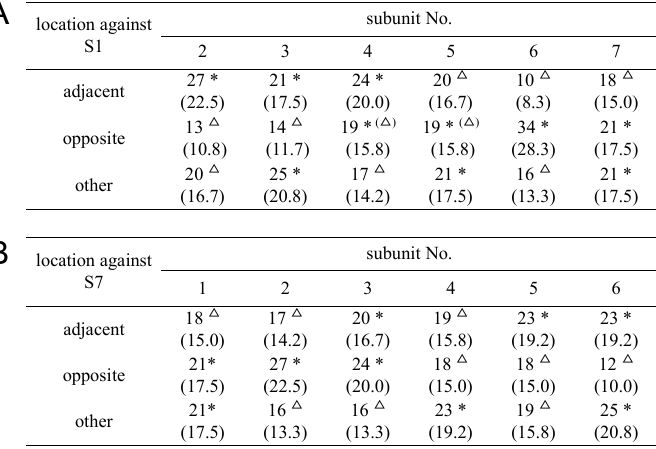
The number of each subunit located at “adjacent,” “opposite” and “other” is counted in the 60 pores on the basis of S1 (A) and S7 (B). The top three subunits located at each position at high-probability are marked with asterisks. In contrast, the worst three subunits located at each position are marked with triangles. The numbers in parentheses mean the probability (percentage) in 60 pores. By using the top three subunits at high-probability and three worst subunits, HP and LP arrangement patterns were created as shown in Fig. 3 and 4.